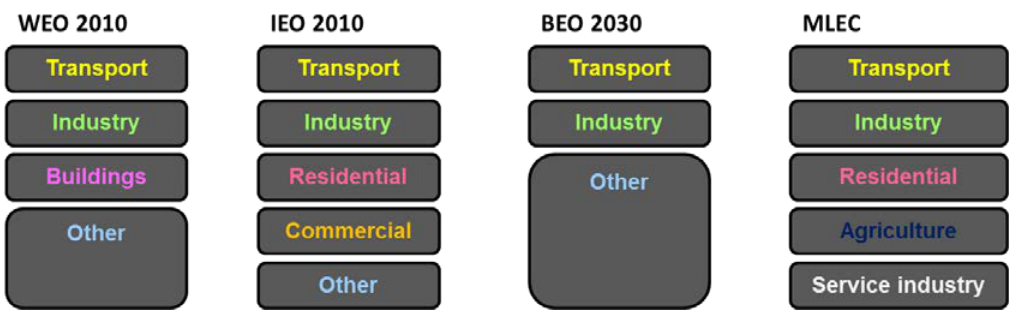
Figure 8. Energy consumption